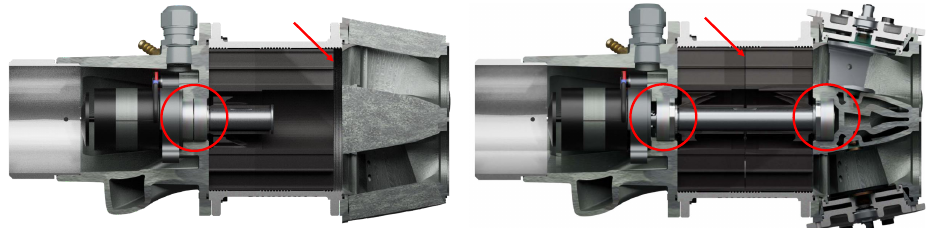
Figure 3. Different Comprex designs. In both designs, the fresh air housing is located on the left- hand side and includes the drive motor, while the exhaust gas housing is located on the right-hand side. The circles indicate the bearing locations, and the arrows point to the location of the gap that compensates the thermal elongation of the rotor. ( Left ) Old design, bearings only in the air-side housing, one-piece rotor. ( Right ) New design, one bearing in each housing, two-piece rotor with a central